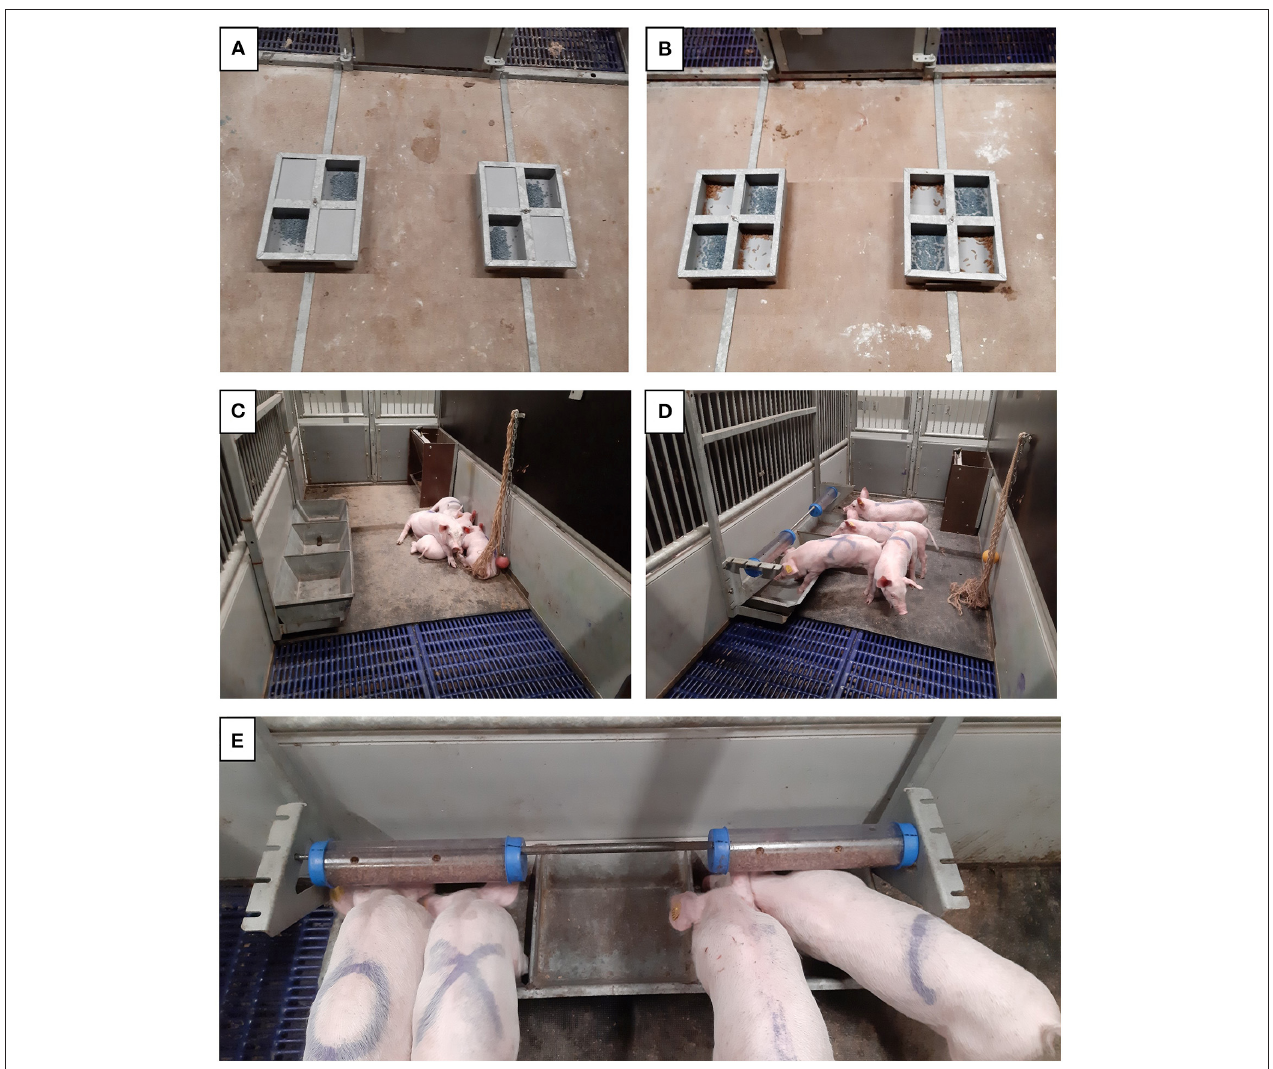
FIGURE 1 | Set-up of the pre- and post-weaning treatments. From d3 pre-weaning, piglets could access the feeding area that contained either two feeders with two feeding spaces containing creep feed (A) , or two feeders with four feeding spaces, two containing creep feed and two containing larvae (B) . Post-weaning, piglets either had access to an empty feeder (C) , or access to a feeder to which two horizontally suspended tubes containing larvae were attached (D) . A close-up of the tubes filled with larvae can be seen in (E)